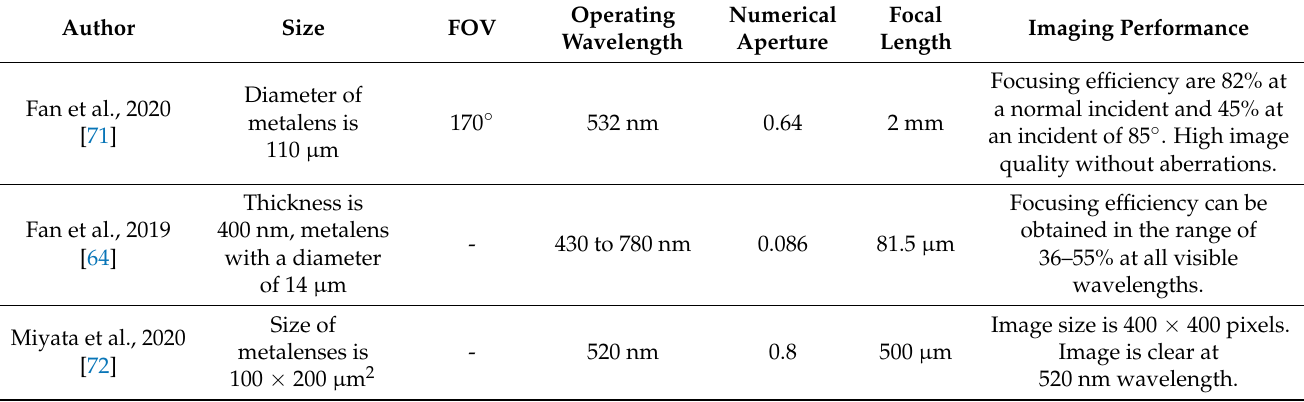
Table 6. The parameter and performance of the artificial compound eye using dielectric metasurface-based